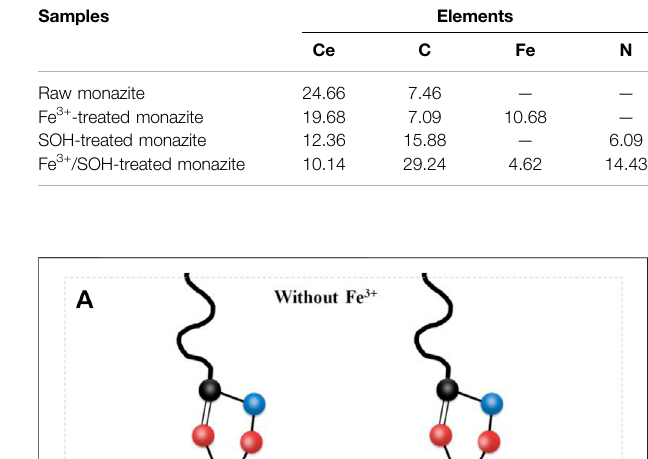
TABLE 2 | Atomic proportions (at. %) of Ce, Fe, and N elements on the monazite surface. Samples